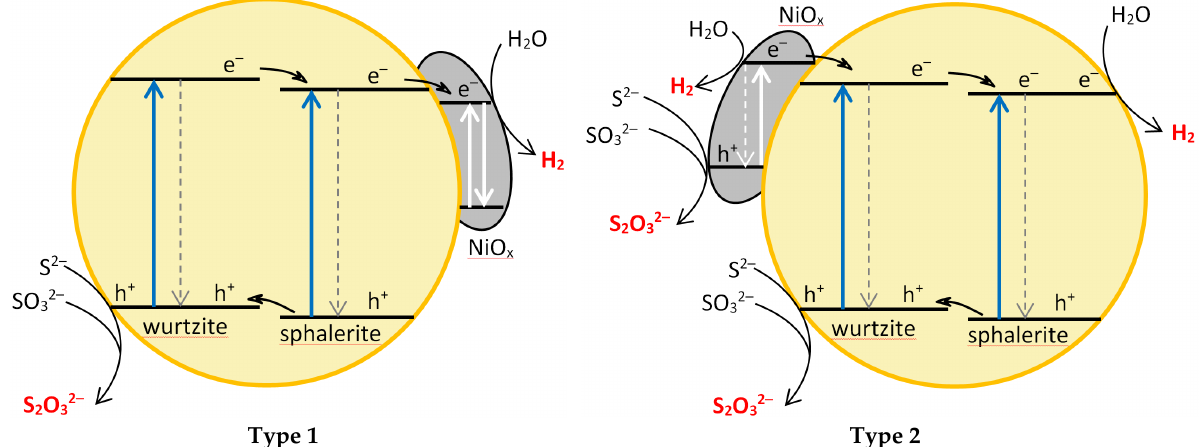
Figure 7. Schematic illustration of the proposed role of NiOx co-catalyst for enhancing the RHP.